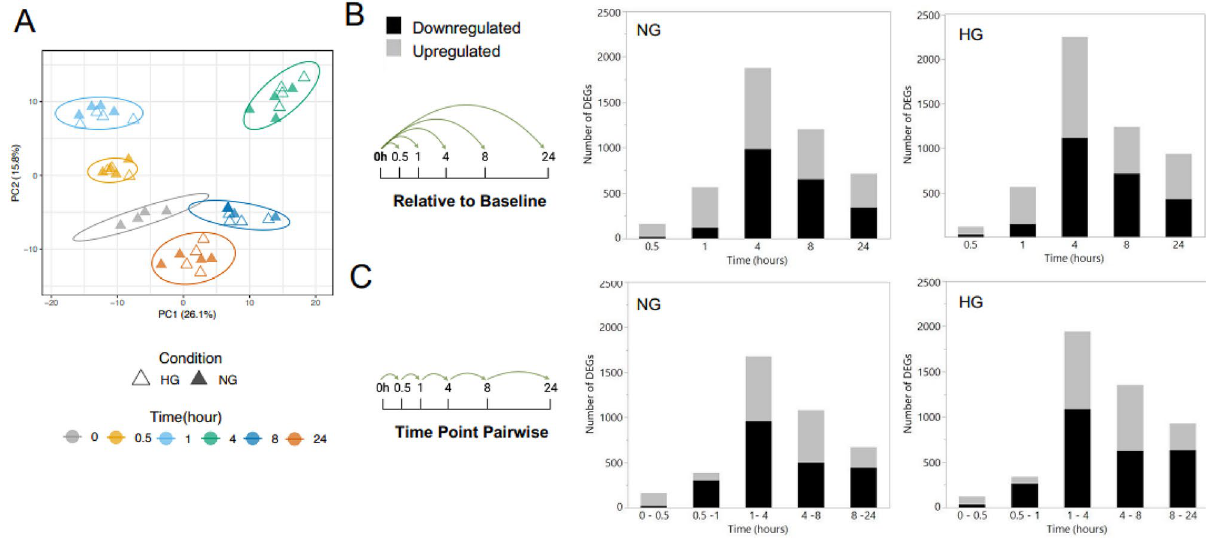
Figure 2. The temporal effect of glucose treatment on the HAEC transcriptome. ( A ) PCA of each time point in NG (5.5 mM d-glucose) or HG (25 mM d-glucose) conditions. Schematics show the pairwise comparisons of the baseline sample (NG 0 h) with each treatment time point (NG/HG 0.5, 1, 4, 8 or 24 h); ( B ) or between time points (0–0.5, 0.5–1, 1–4, 4–8 and 8–24 h); ( C ) that was applied for differential gene expression analysis evaluated by analysis of variance (ANOVA), using the Basic Expression workflow implemented in JMP Genomics 8 (SAS Institute). Graphs show the number of DEGs (± 1.2 fold change, adjusted p-value < 0.05 as statistical significance threshold) that are up (grey bars) or downregulated (black bars) in either NG or HG conditions compared to baseline ( B ) or the previous time point ( C